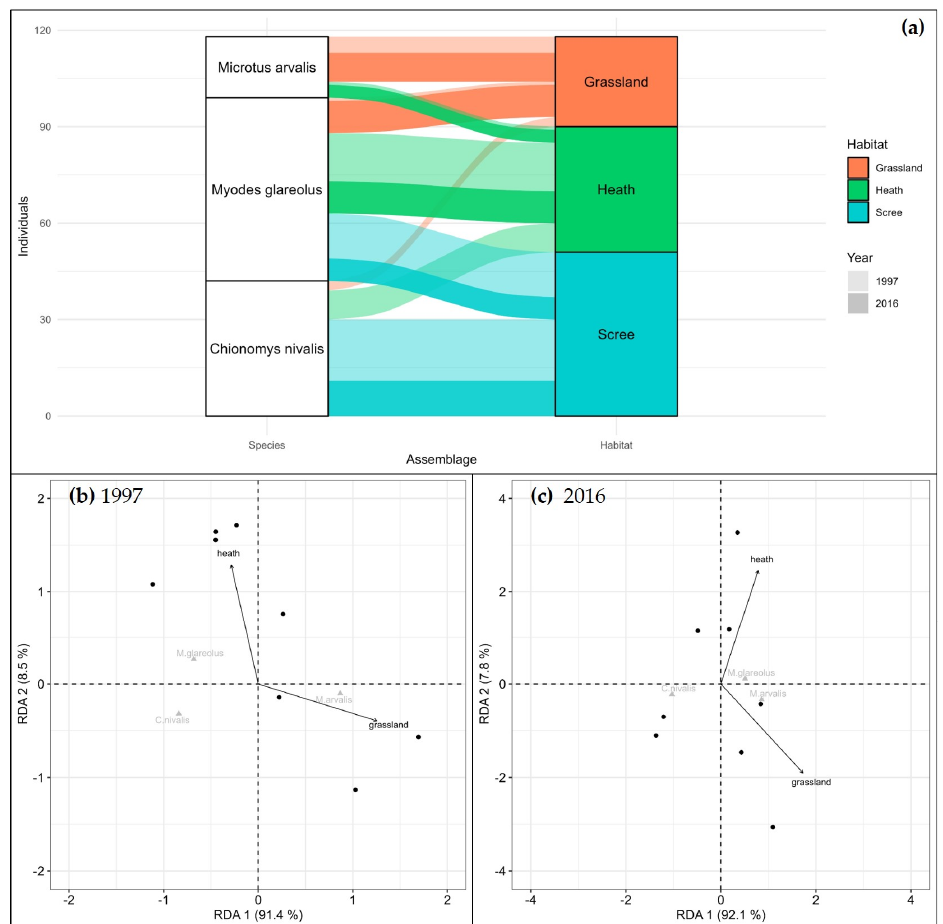
Figure 2. ( a ) Alluvial plot visualizing frequency distributions of small rodent species across habitat types in 1997 and 2016. ( b , c ) An RDA biplot showing the association between small rodents and habitat types in 1997 ( b ) and 2016 ( c ).